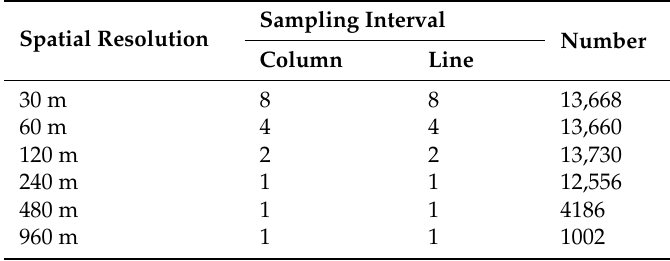
Table 1. The number of training samples at different spatial resolutions. Sampling Interval Spatial Resolution